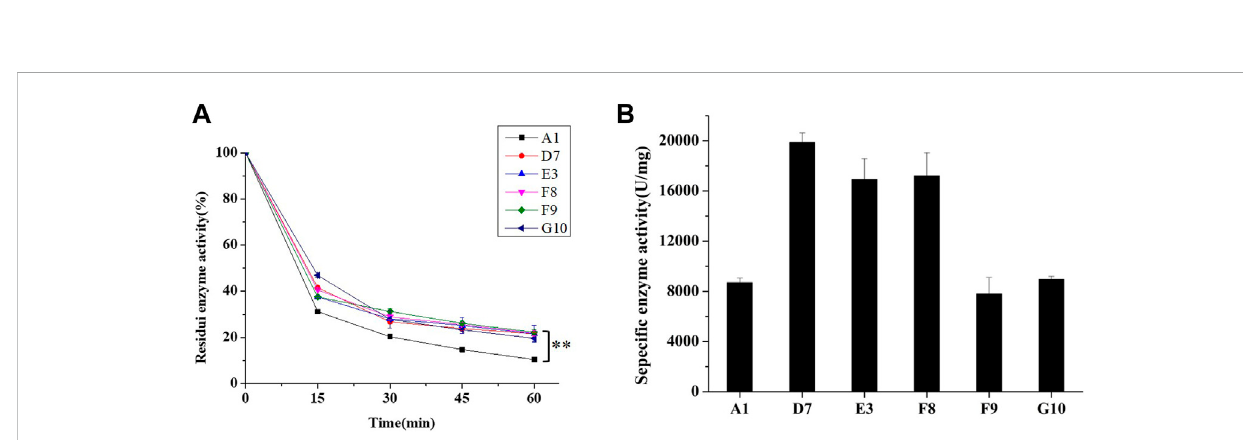
Characteristics of parent and mutants expressed in P. pastoris . (A) Residual activities of parent and mutants after treatment at 99 ° C for 60 min. (B) Speci fi c enzyme activities of parent and mutants (determined at 37 ° C, pH 5.5). For statistical analysis, t -test was performed to compare to wild-type (A1) after treatment at 99 ° C for 60 min, asterisks represent signi fi cance: **, p < 0.01; n =